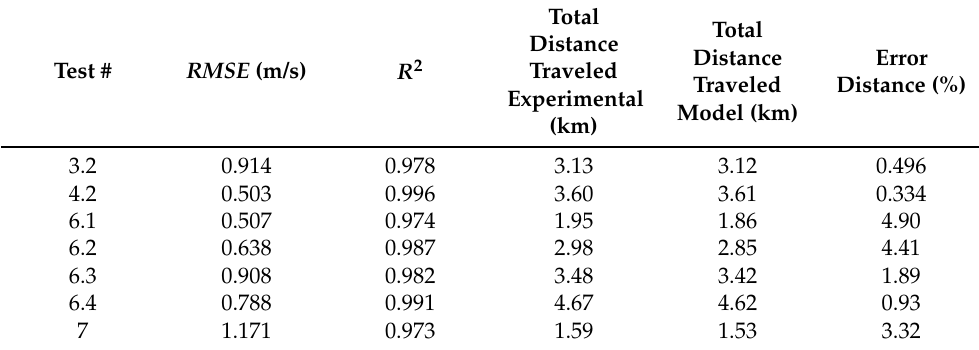
Table 13. Prediction metrics of vehicle model performance over testing datasets.